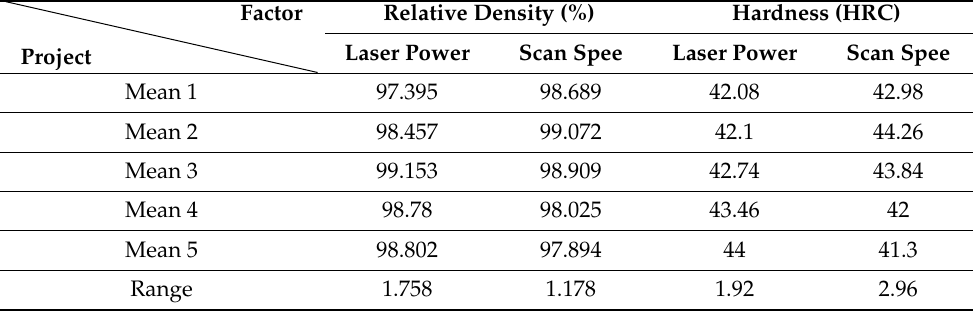
Table 3. Range analysis of the orthogonal